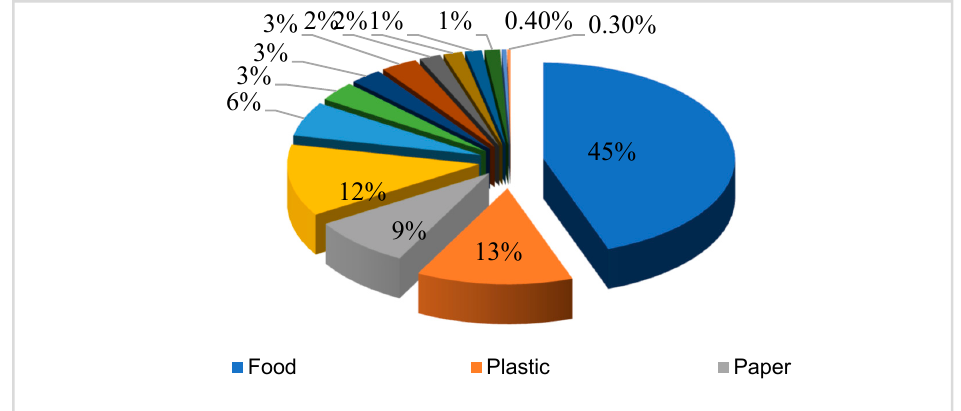
Figure 3. Malaysian waste fraction [8].